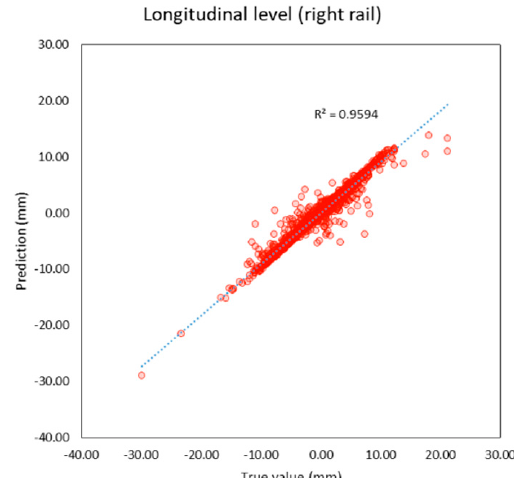
Figure 5. Correlation between true and predicted values of superelevation.